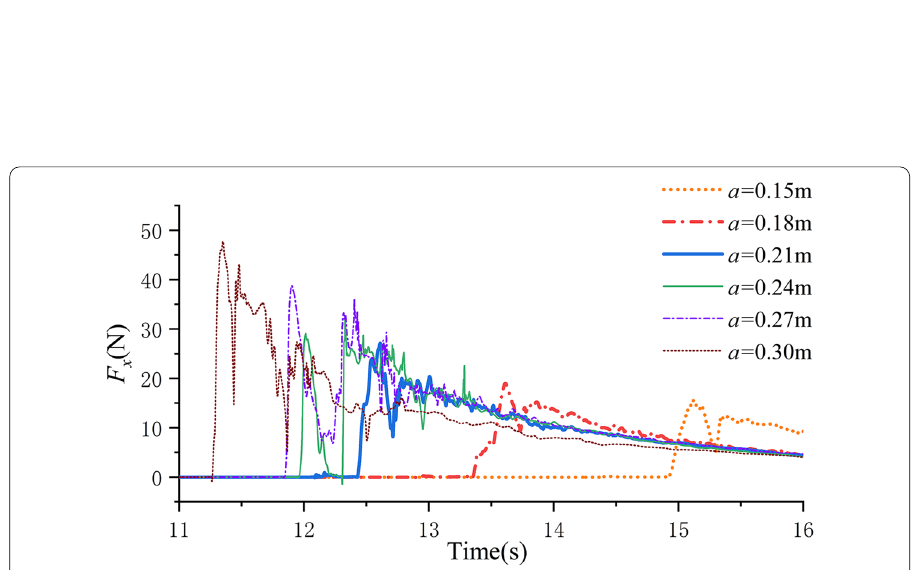
Fig. 21 Comparison of time histories of horizontal forces of the cases with different wave